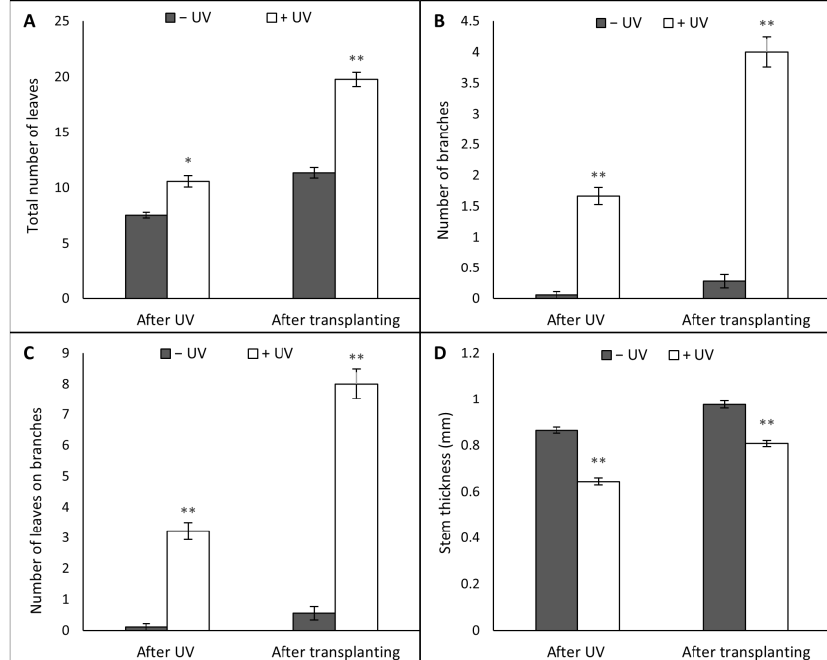
Figure 3. Parameters measured were the total number of leaves ( A ), the number of branches ( B ), the number of leaves on branches ( C ) and stem thickness (mm) ( D ) . Before the UV exposure stage, the mean of the total number of leaves was equal to 6, the number of branches and the number of leaves on branches was equal to 0, while the stem thickness was 0.558 mm. Asterisks indicate a significant difference between the UV treatments with p < 0.05 (*) or p ≤ 0.001 (**). UV exposure leads to a reduction in plant size, indeed plants exposed to UV are significantly shorter than plants grown under the UV-blocking filter after both the UV exposure stage and the recovery stage ( p < 0.001) (Figures 2A and 4A). UV also affects the internode length causing a reduction both immediately after UV exposure ( p < 0.001) and after transplanting ( p < 0.001) (Figure